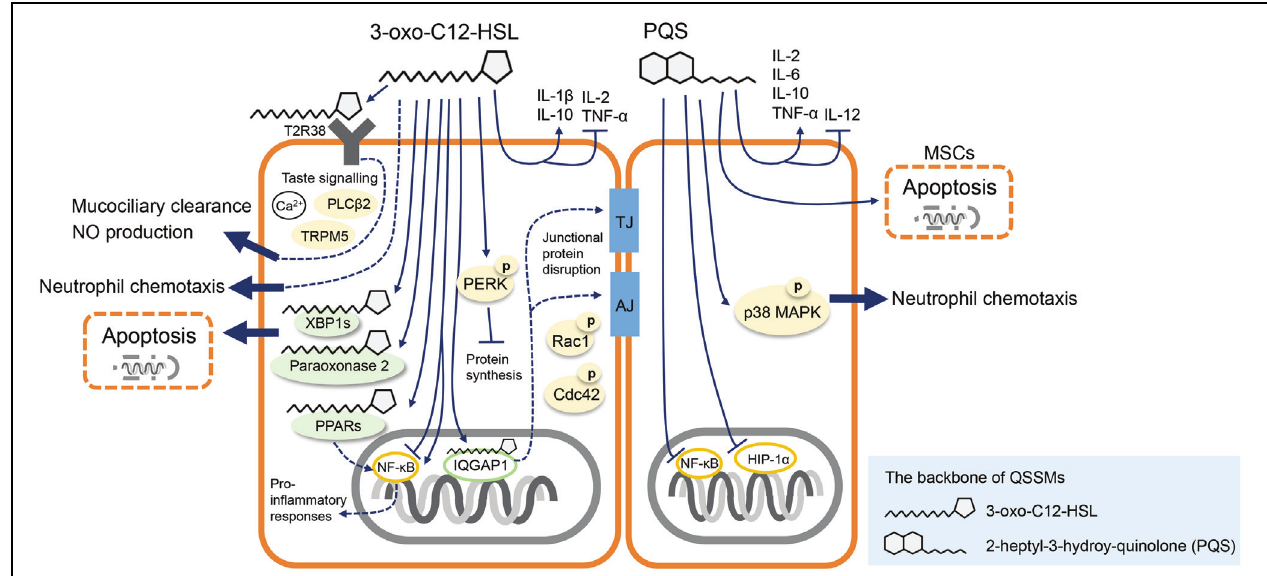
FIGURE 1 | Schematic illustration of the best characterized Pseudomonas aeruginosa quorum sensing signal molecules (QSSMs) that interfere with mammalian host biological functions. P. aeruginosa 3-oxo-C12-HSL targets XBP1 and paraoxonase 2 leading to host cell apoptosis, and the binding of 3-oxo-C12-HSL with IQGAP1 impairs the host cell integrity. 3-oxo-C12-HSL modulates innate immune responses via the activation of T2R38 receptor and inhibition of NF- κ B pathways. P. aeruginosa Pseudomonas quinolone signal (PQS) molecule induces MSCs apoptosis, induces the secretion of inflammatory cytokines via the inhibition NF- κ B and HIP-1 α pathways. PQS molecule interferes with neutrophils chemotaxis potentially through the activation of p38 MAPK pathways. See text for details. PLC β 2, phospholipase C β 2; TRPM5, transient receptor potential cation channel subfamily M member 5; PPARs, peroxisome proliferator-activated receptors; TJ, tight junction; AJ, adhesional junction; MAPK, mitogen-activated protein kinase; MSCs, mesenchymal stem